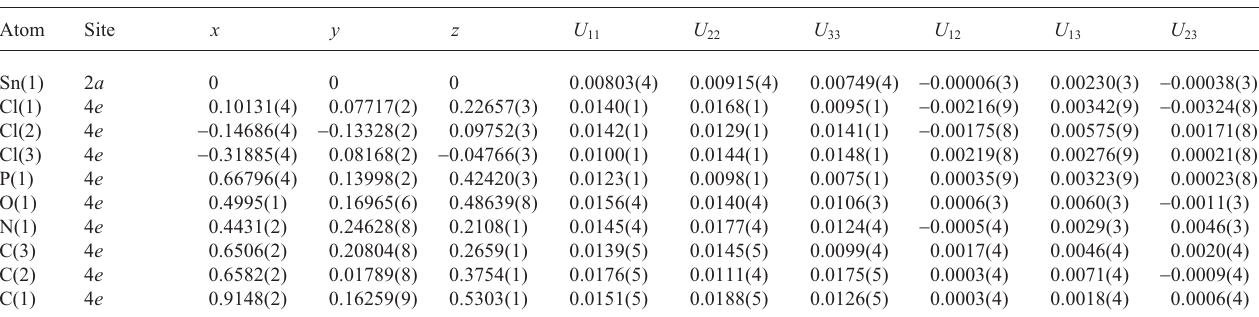
Table 3. Atomic coordinates and displacement parameters (in Å 2 )